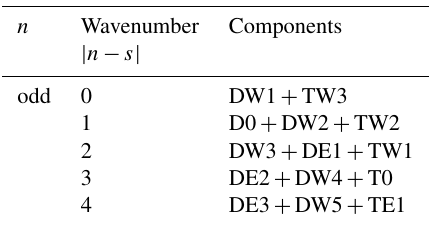
Table 1. Main tidal component contributions resolved in our spec- tral analysis. The derived amplitudes and phases are a combination of all modes